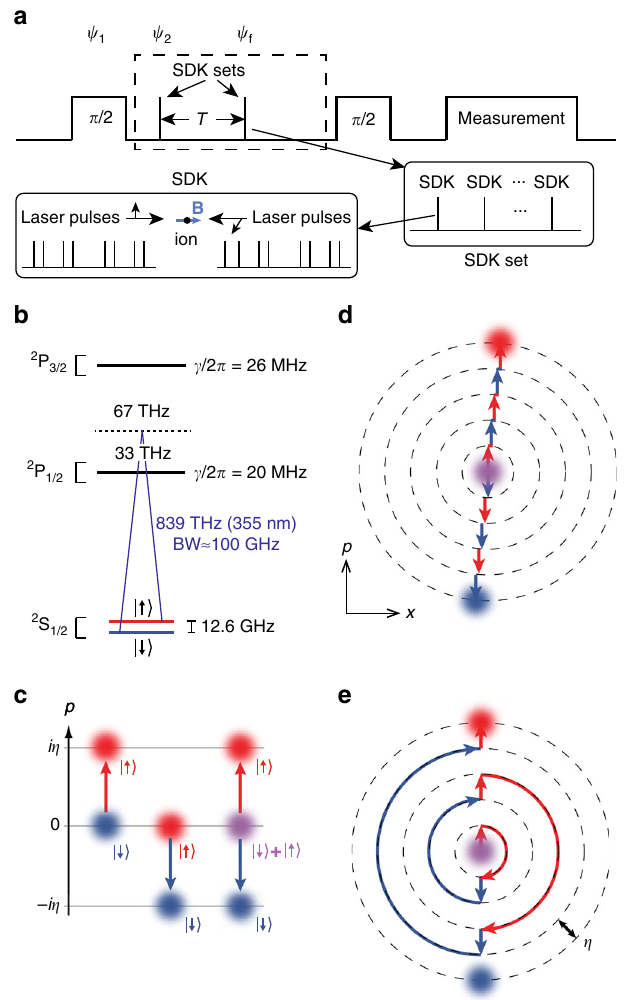
Fig. 2 Experimental schedule and coherent state control. a Spin-dependent kicks (SDKs) are concatenated to generate cat states. The kicks are inserted between two Ramsey microwave π /2 pulses with a variable relative phase, and fi nally the interference of the motional states, after being separated for a time T , is measured on the qubit state. Counter-propagating pulses have linear orthogonal polarisations and are orthogonal to an applied magnetic fi eld B . b Each SDK originates from position-dependent stimulated Raman transitions driven by counterpropagating laser beams near a wavelength of 355 nm. c A single SDK displaces a coherent state by ± 2 ħ k in momentum space (or ± i η in natural units of ħ / x 0 ), with the sign depending on the initial qubit state ( red : "j i or blue : #j i ), and splits a qubit superposition ( purple : "j i þ #j i ). Each momentum transfer is accompanied by a spin fl ip. d SDKs are concatenated by changing the direction of the laser beams between each kick, with every pulse from a mode-locked laser used to increase the cat state separation. e Alternatively, SDKs are concatenated by timing the kicks to occur at each half-period of oscillation of the ion in the trap. (The arrows only track population initially in #j i , but the fi nal state is still shown by including the blue #j i component.) Free evolution appears in fi gures d , e as circular